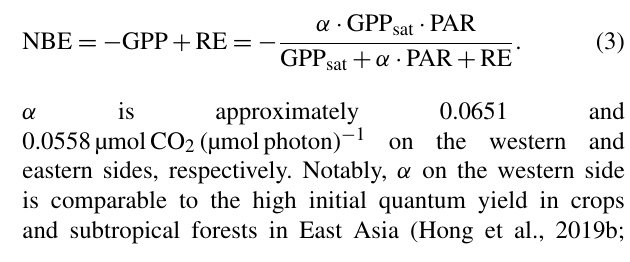
PAR ( F C_0 ) is larger on the western side (9.7 µmol m − 2 s − 1